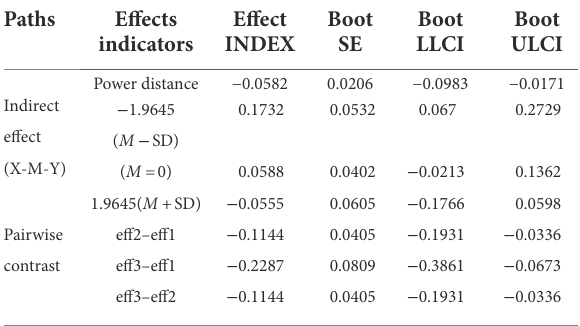
TABLE 5 Moderated mediating